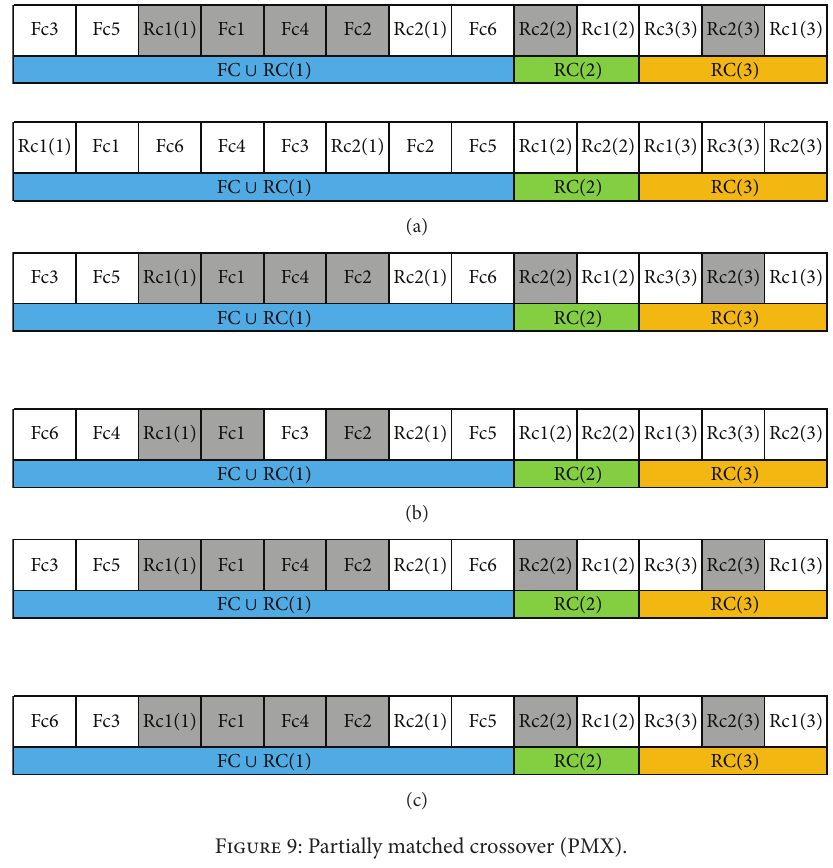
Figure 9: Partially matched crossover